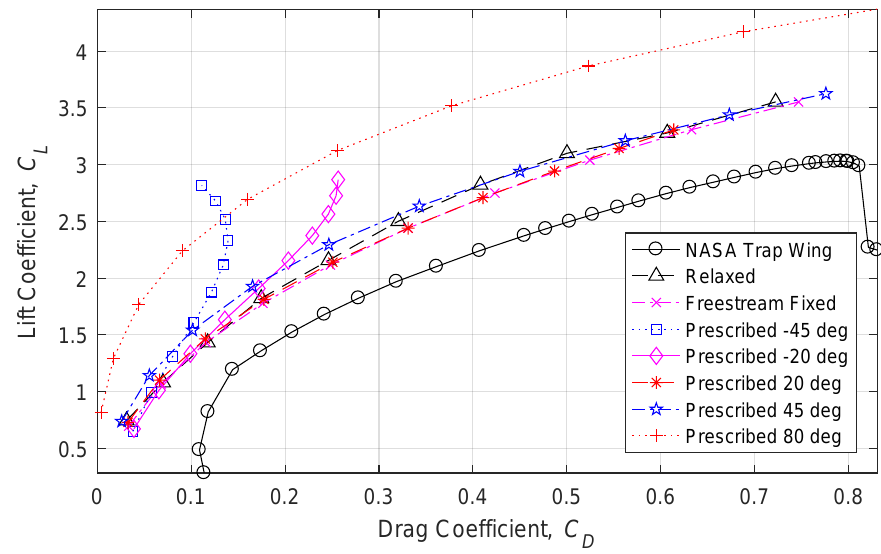
Figure 14. Comparisons of induced drag predictions using several wake types, and experimental observations of drag, for the NASA Trap Wing LaRC Configuration